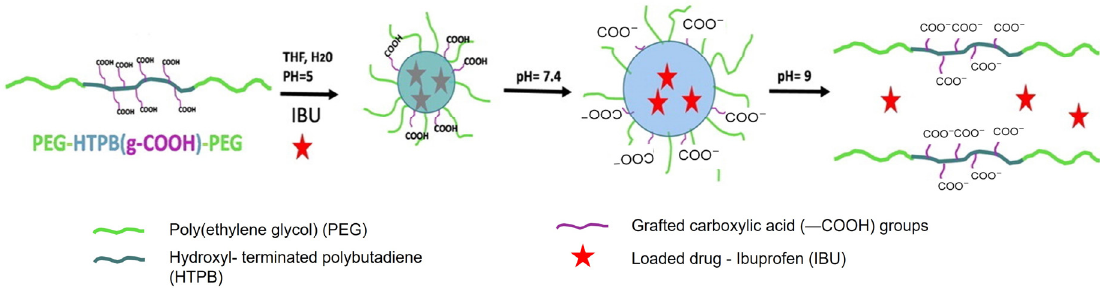
Figure 10. Formation of micelle at pH 5, swelling of micelle at pH 7.4 and dissociation of carboxylic groups at pH 9 (Adapted and reprinted with permission from ref. [81] © 2016,